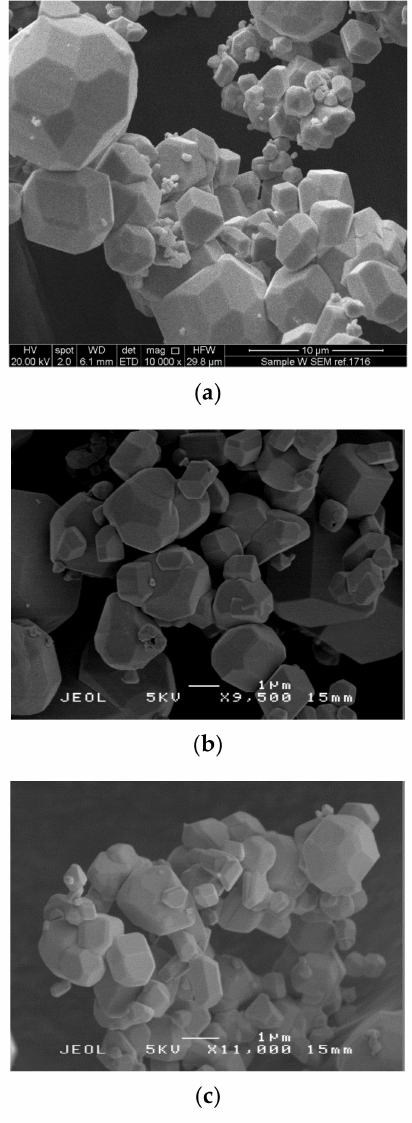
Figure 1. Scanning electron micrographs of ( a ) tungsten, ( b ) tungsten oxide and ( c ) tungsten carbide